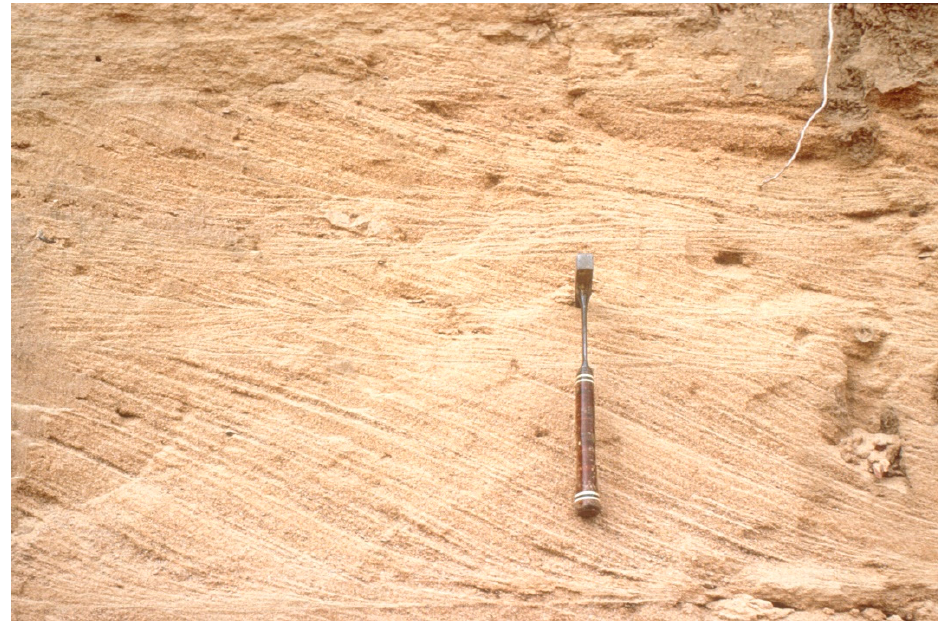
Figure A3. Cross ‐ bedded sands of the Baghor Formation Lower Member, Middle Son valley, north ‐ Figure A3. Cross-bedded sands of the Baghor Formation Lower Member, Middle Son valley, north- central India. central